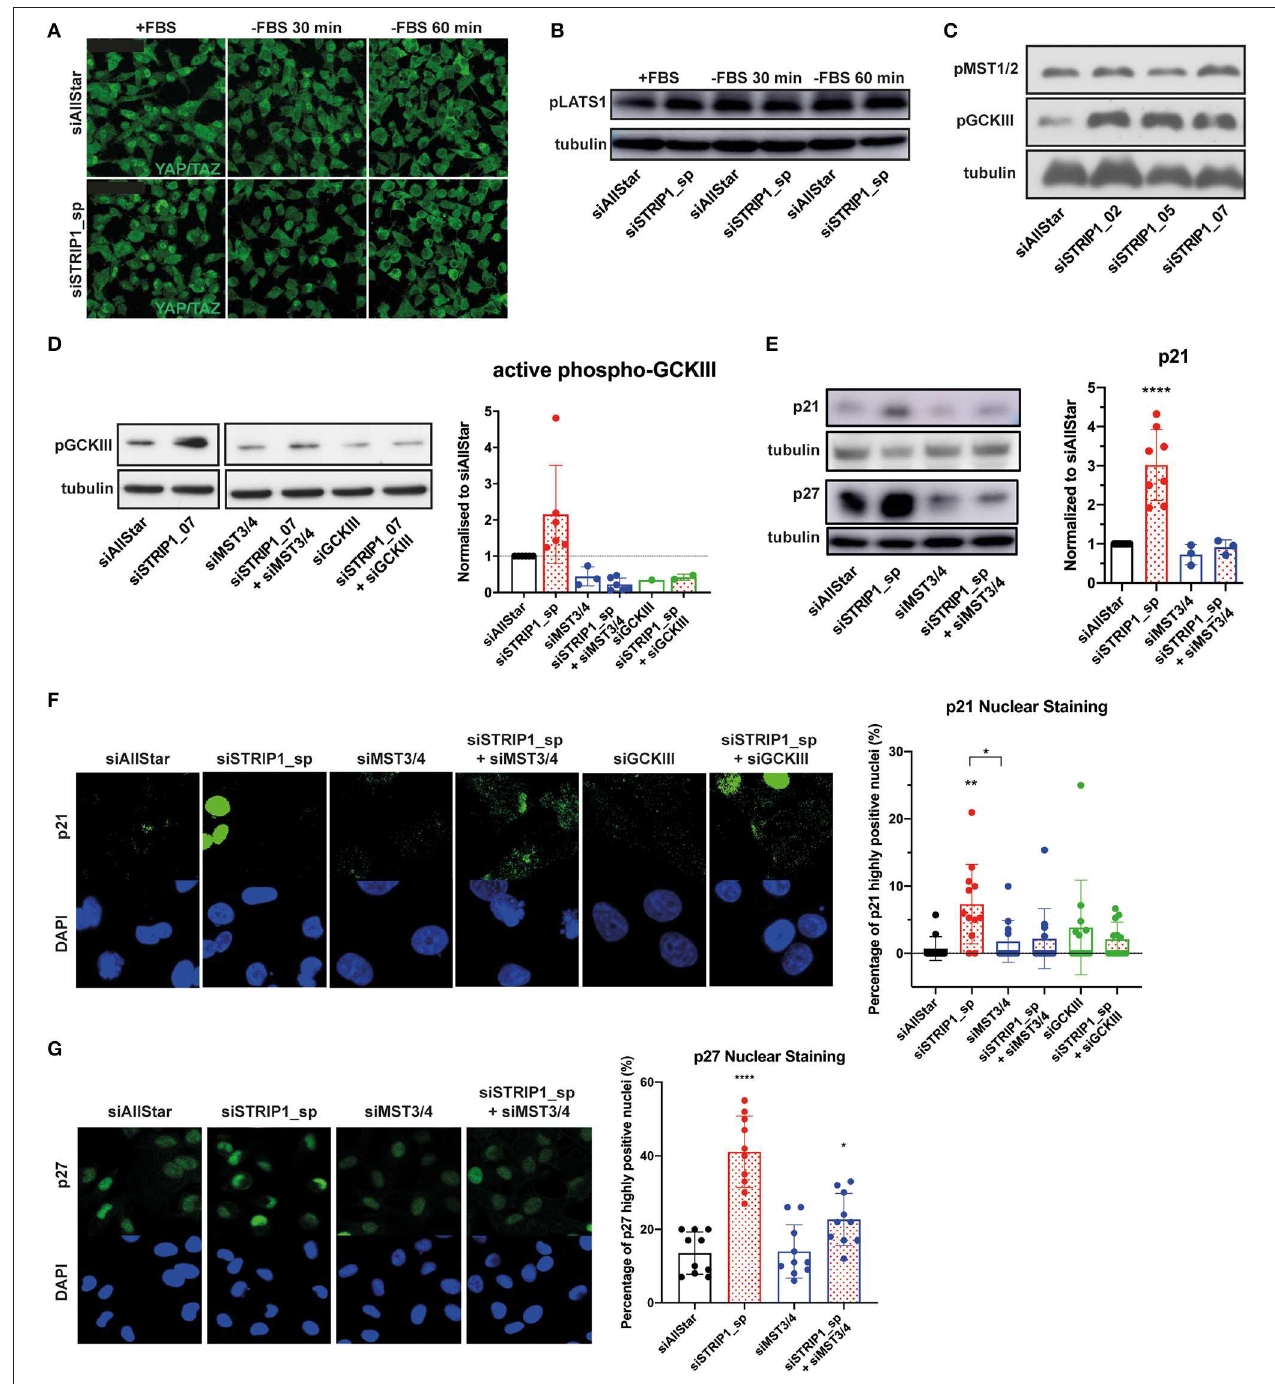
FIGURE 3 | p21 and p27 induction is regulated by activated MST3&4 kinases. (A–C) Depletion of STRIP1 in MDA-MB-231 cells does not affect Hippo signaling and YAP/TAZ localization. (A) Immunofluorescence analysis of YAP/TAZ localization after STRIP1 depletion in normal media conditions and serum starvation for 30 and 60min. (B) Immunoblotting analysis of phospho-S909-LATS1 under normal media conditions and serum starvation for 30 and 60min. (C) Immunoblotting analysis demonstrates that loss of STRIP1 does not induce phosphorylation of MST1/2. On the contrary, loss of STRIP1 induces strong phosphorylation of the three kinases MST3, MST4, and SOK1 forming the Germinal Center Kinase III (GCKIII) complex. (D) Loss of STRIP1 induces auto-phosphorylation of activation loop of the GCKIII complex, as demonstrated by rescuing the effect using kinase specific siRNAs. Included quantification of activated phospho-GCKIII in siRNA-depleted MDA-MB-231 cells. The data shows that loss of STRIP1 induces activation of GCKIII in a MST3&4 dependent manner. (E) Immunoblotting analysis demonstrates that siRNA